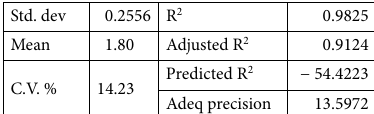
Table 4. Fit statistics of the quadratic